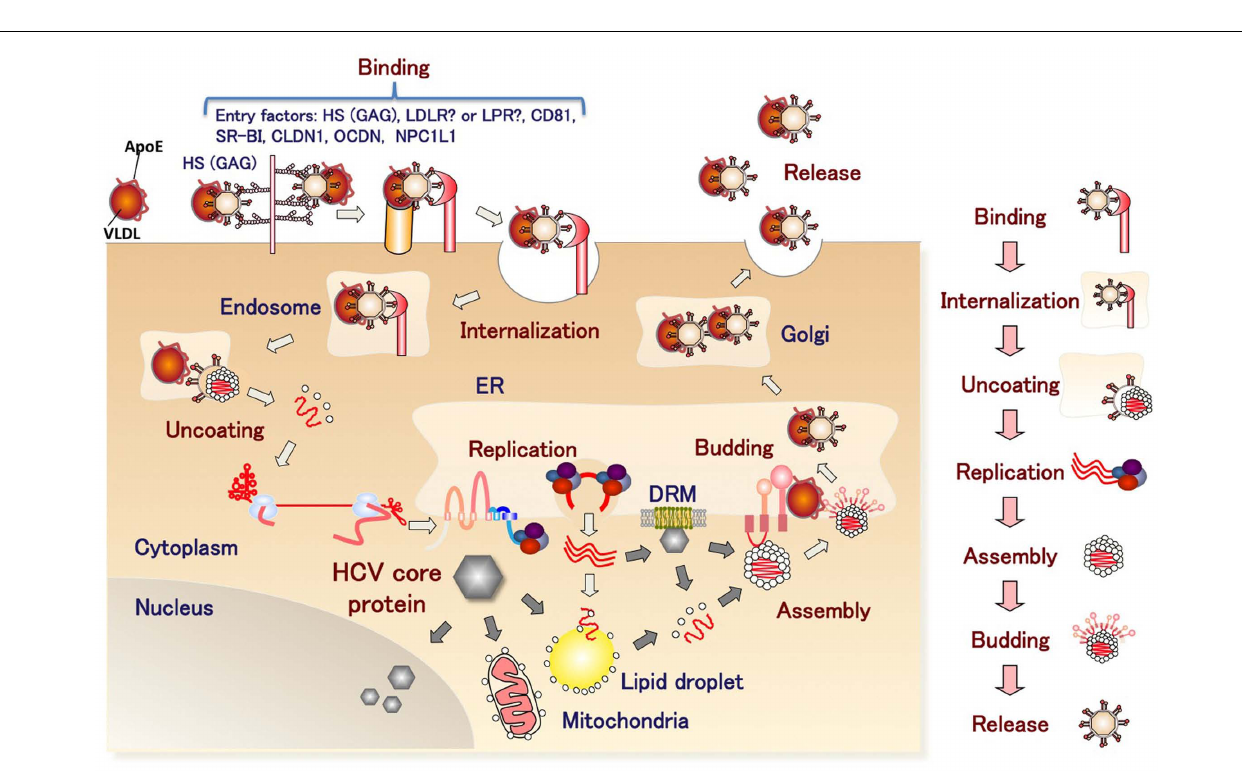
FIGURE 2 |The infection cycle of HCV. The HCV complex withVLDL binds to entry factors on the surface of hepatocytes and then enters cells by endocytosis. After uncoating, viral replication is carried out in the convoluted